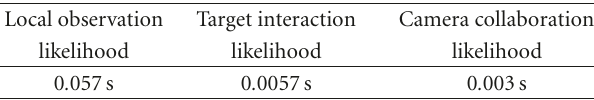
Table 1: Average computational time comparison of di ff erent like- lihood